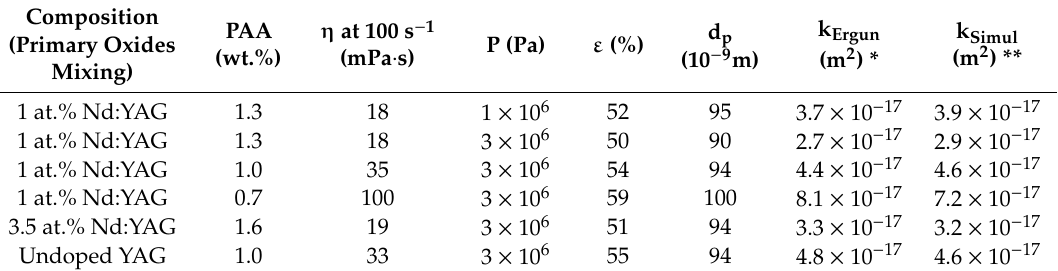
Table 1. Pressure slip-casting parameters and comparison of the calculated permeability with experimental values obtained for suspensions with 30 vol.% and pH = 9.